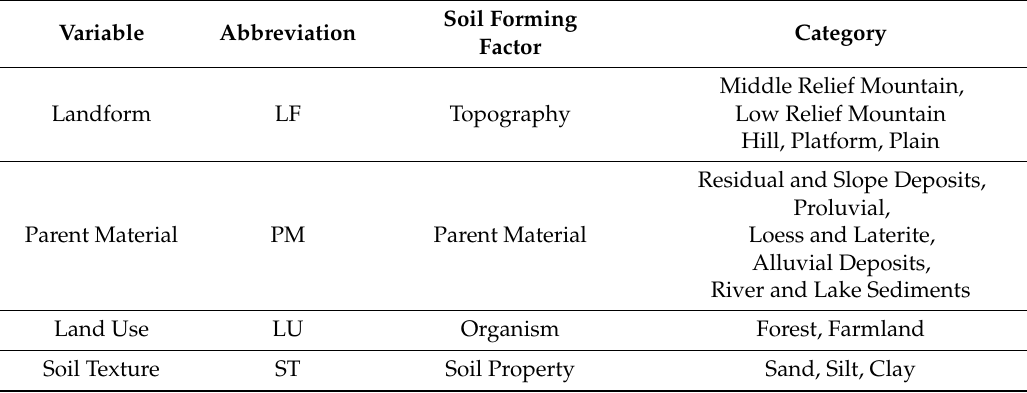
Table 2. Qualitative environmental variables used in this